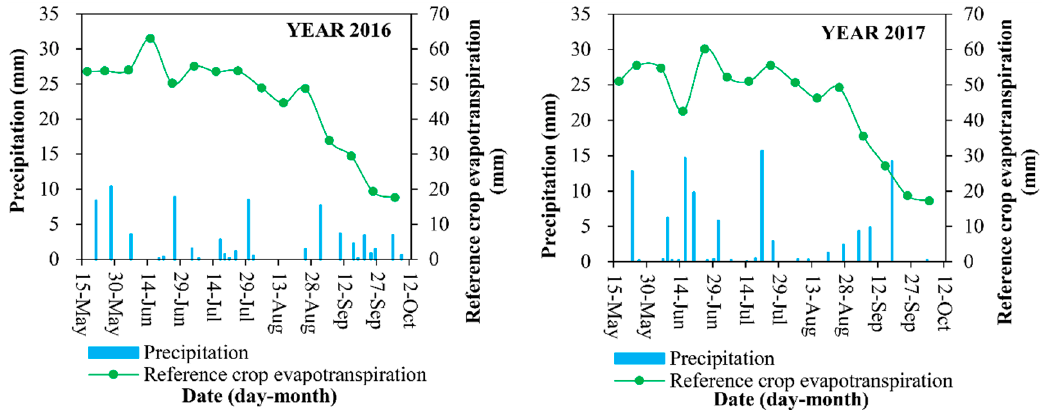
Figure 1. The reference crop evapotranspiration and precipitation during the growing period of maize in 2016 and 2017.